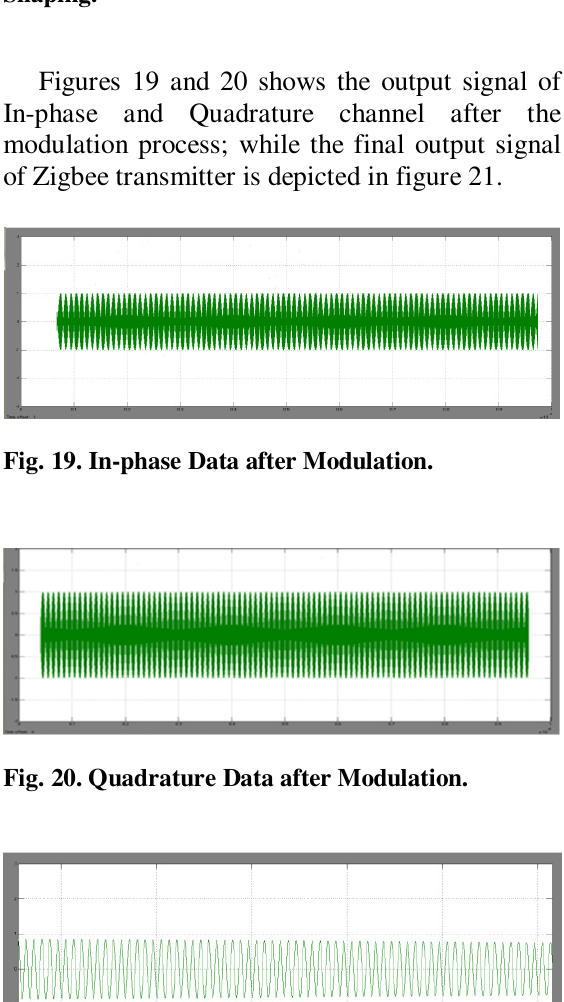
Fig. 13. Input data after Applying DSSS Technique.